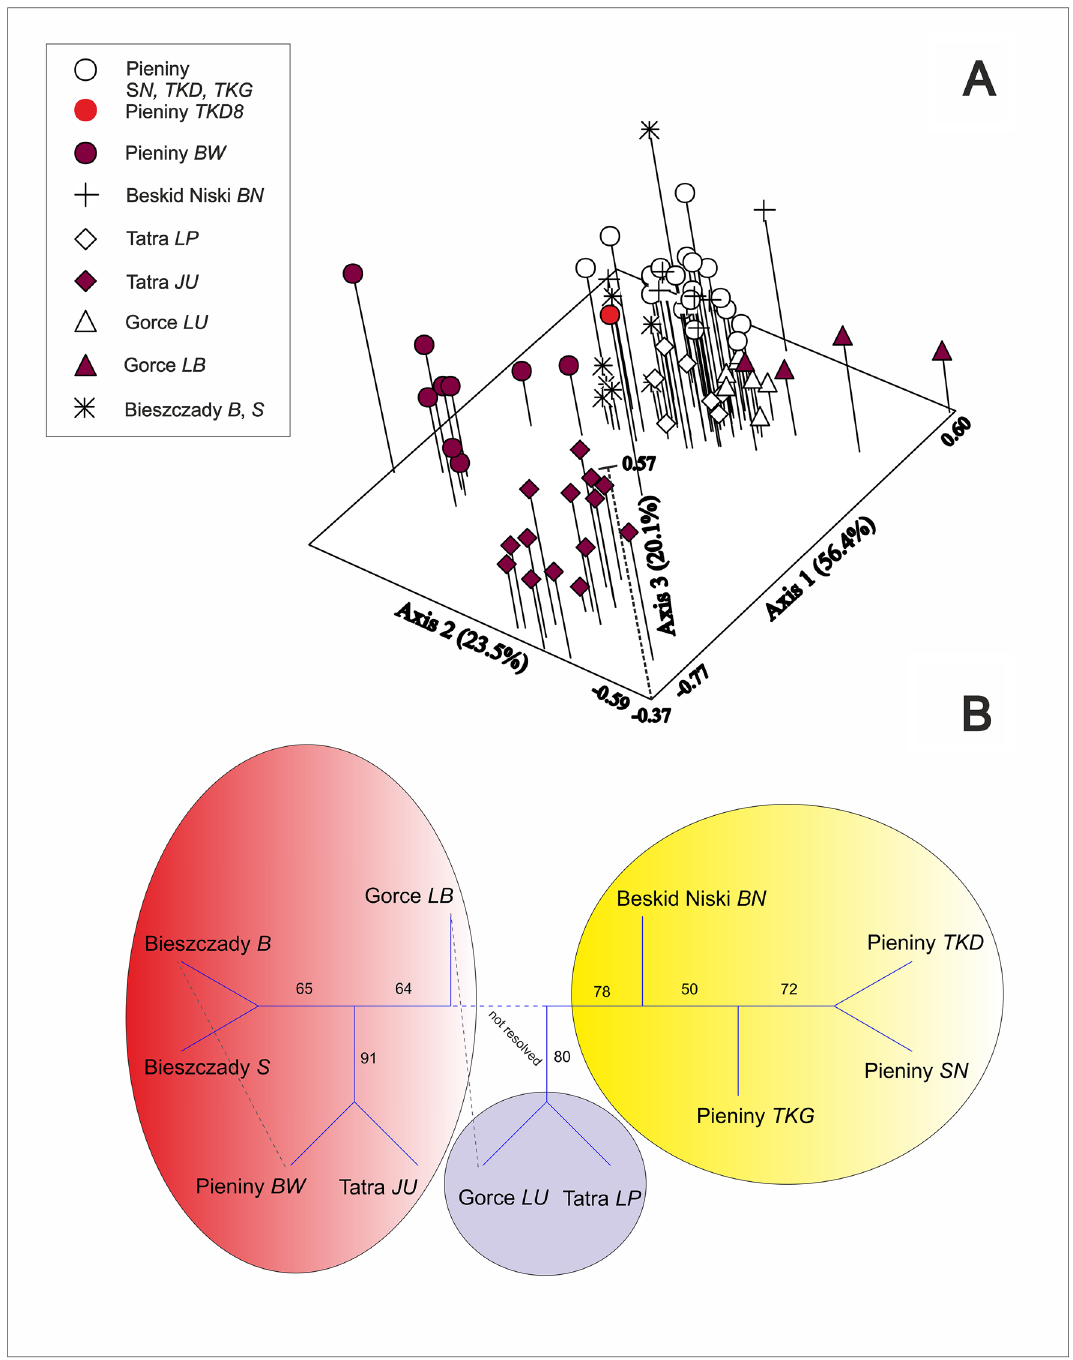
Figure 2. Results of numerical analyses of 11 populations and 77 individuals of Gladiolus imbricatus in Polish Carpathians based on 168 ISSR bands. (A) Non-metric Dimensional Scaling (NMDS, Dice distance, NTSYSpc 47 ); (B) neighbour joining (NJ) classification with reticulations (T-REX 42 ). The unrooted tree is based on Nei’s distance. Figure by